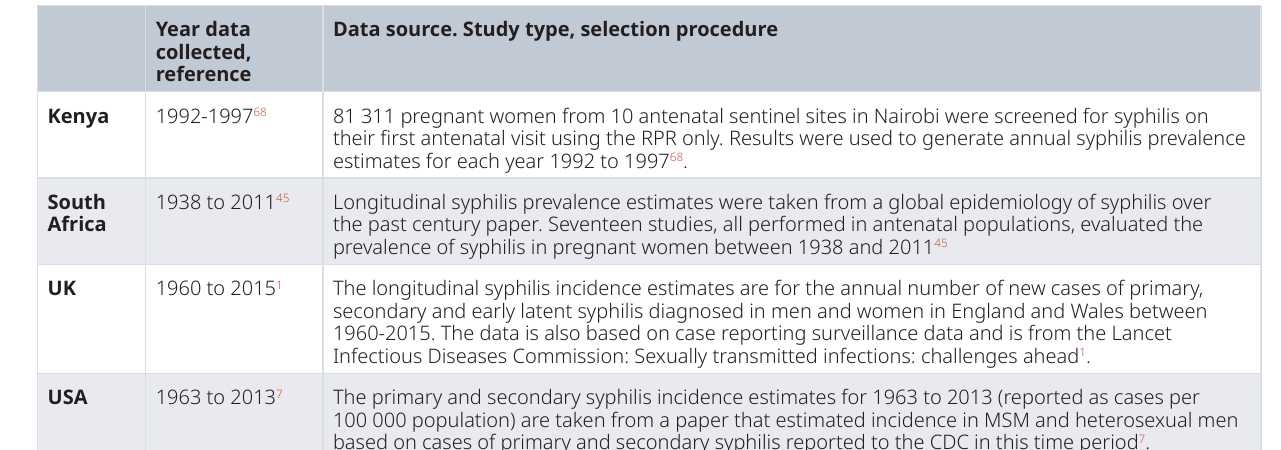
Table 3. Description of sources of data for longitudinal changes in syphilis incidence and prevalence. Year data